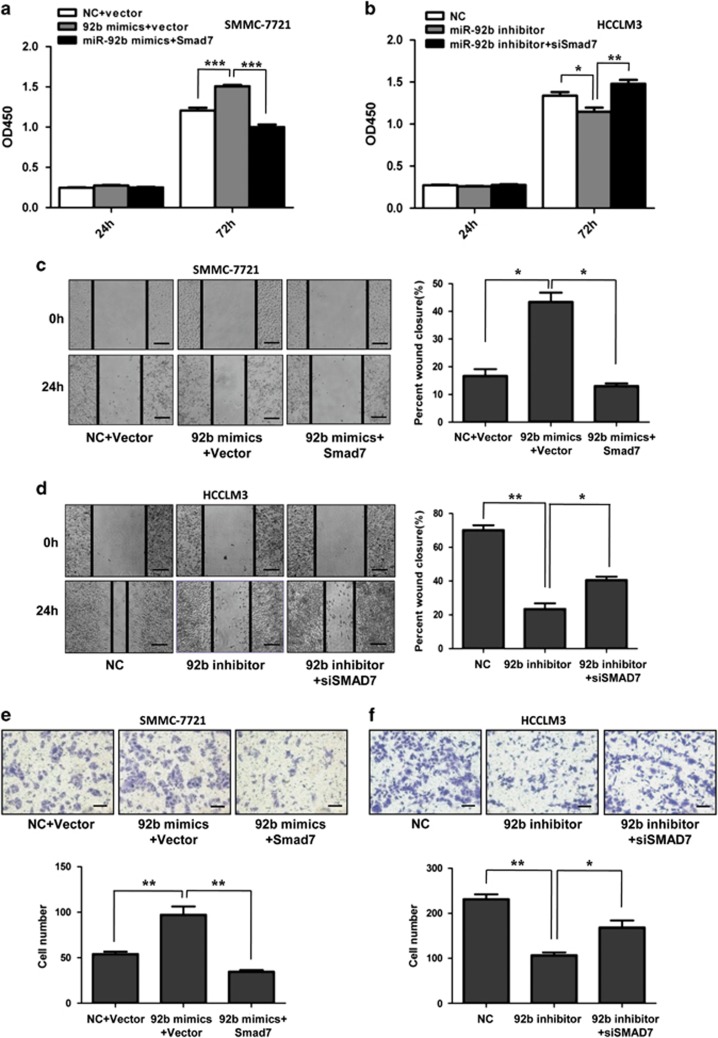
Smad7 mediates the effects of miR-92b on proliferation and metastasis of HCC cells. SMMC-7721 cells with miR-92b overexpression were transfected with Smad7-expressing plasmids, and HCCLM3 cells with miR-92b knockdown were transfected with Smad7 siRNA. (a and b) CCK-8 assays, (c and d) wound healing assays and (e and f) transwell invasion assays were performed. The percent of wound closure or the number of cells having passed through the membrane were counted and compared in the diagrams. Results were represented as mean±S.D. (n=3). *P<0.05; **P<0.01. Scale bars represent 500 μm (c and d) and 200 μm (e and f), respectively